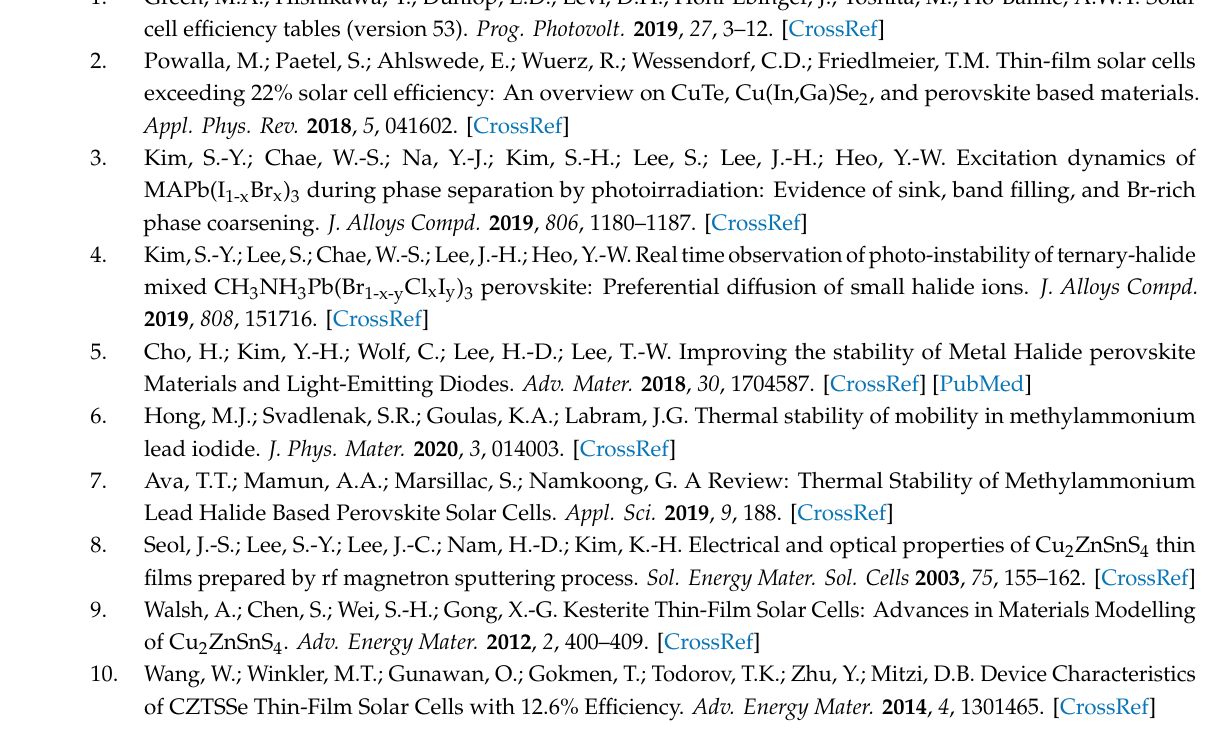
Figure S1: Wettability of bare-Mo, BOE-etched Mo, and Al 2 O 3 coated Mo; Figure S2: FESEM images of (a) top view and (b) bottom view of lifted-o ff CZTSSe of the sample with a passivation area of 56%; Figure S3: Lift-o ff process of CZTSSe cell, and Figure S4; Depth-profiles of each CZTSSe device by